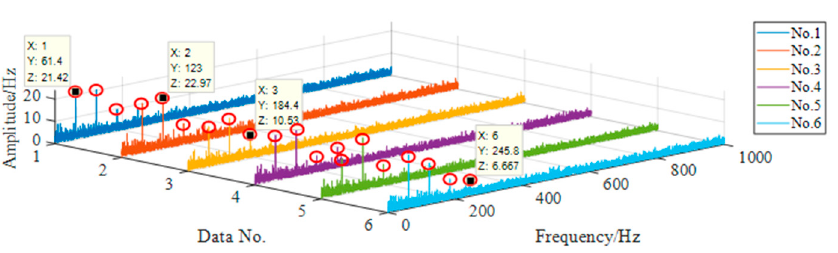
Figure 18. Characteristic frequency distribution of rolling element fault.